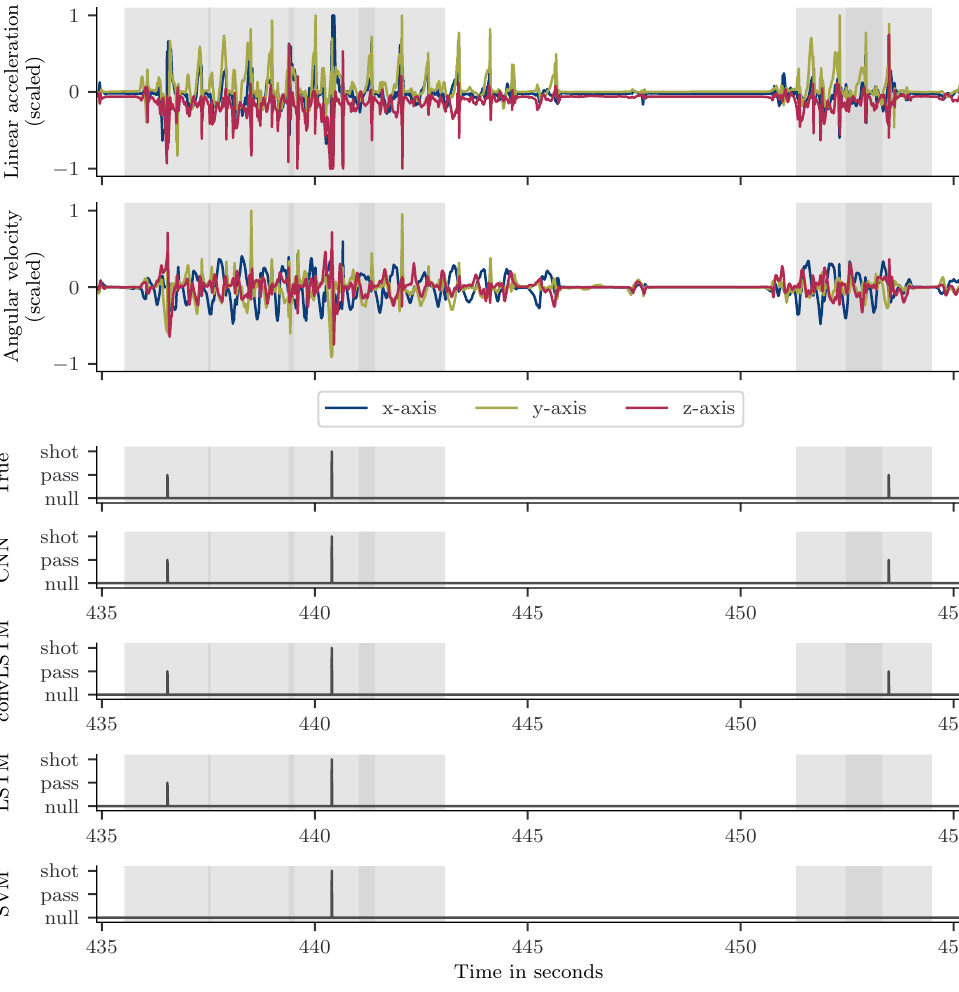
Figure 4. Exemplary accelerometer and gyroscope data excerpt from a laboratory session. The upper two plots show the accelerometer and gyroscope data. Below, the true class label and the predictions by the respective model are shown. At the beginning of the exercise sequence, the player is standing. He passes the ball (second 436) and sprints towards the goal. After receiving the ball back from another player (second 439), he dribbles towards the goal and shots (second 440.5). He runs to a cone, where he is standing until second 451. Then, he sprints towards the ball and passes it to another player at second 453. The peak detection algorithm identified 6 event